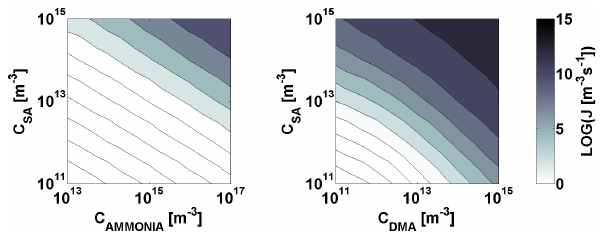
Fig. 1. The particle formation rate in sulfuric acid-ammonia (left panel) and sulfuric acid-dimethylamine (right panel) systems as a function of acid monomer and base monomer concentrations. The colour scale is shown on the right, and gives the base-10 logarithm of the particle formation rate defined in the